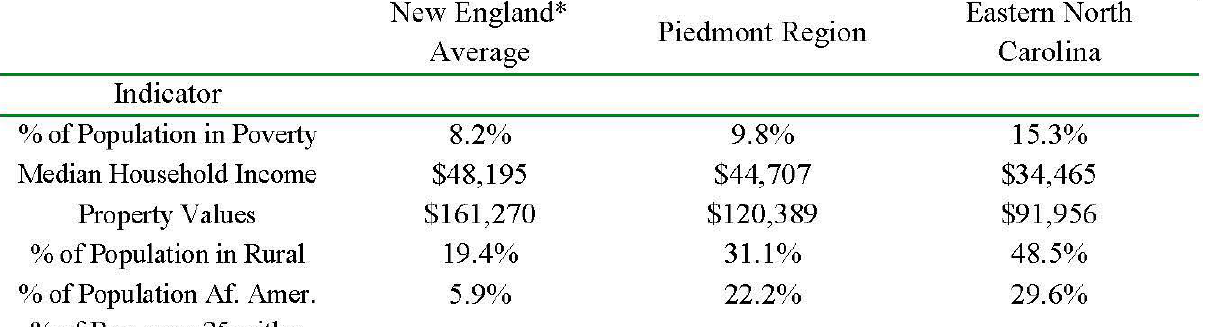
Table 1: Demographic indicators for eastern North Carolina as compared to the averages for the Piedmont region and New England